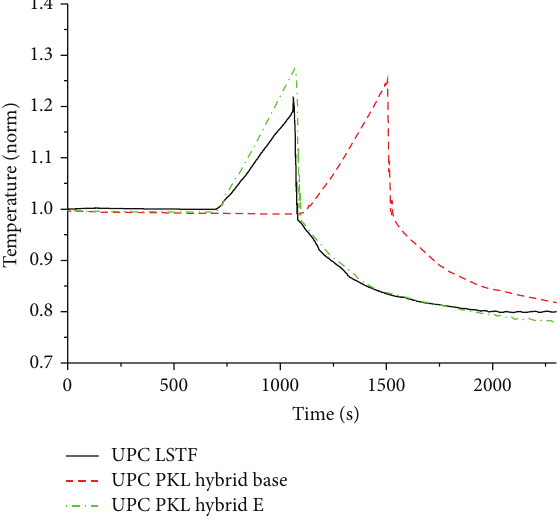
Figure 10: Core exite temperature.